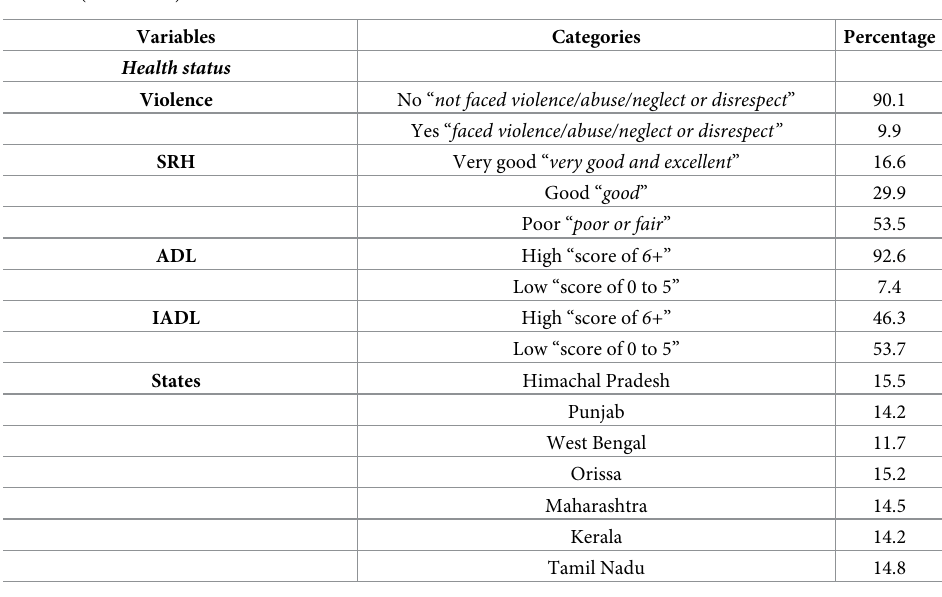
Fig 1A and 1B represent the percentage of living alone/with spouse and reason for living alone/with a spouse. Nearly 21% of older adults were living alone/with a spouse. Additionally, those older adults who lived alone/with spouse had giver specific reasons, i.e. about 14.6% told that they had no children, 47.3% of older adults said that they had their children away and 15.9% of older adults said they live alone/with a spouse because they had a family conflict. Table 2 presents the bivariate association between older adults preferring to live separately over different background variables. We are not discussing these estimates and will primarily focus on adjusted estimates in Table 3 as they provide precise estimates as controlled for back- ground factors. Table 3 represents the probit estimates for older adults who preferred separate living. Old- est-old men had a higher probability of preferred living separate than older adults from the young-old age group [Coef. 0.18, p < 0.05]. The older adults including men and women who were currently in the union had a higher probability of preferring living separate than older adults not in union (Total [Coef. 0.70, p < 0.05], Men [Coef. 0.62, p < 0.05]. Women [Coef. 0.72, p < 0.05].) Older adults including men and women who had years of schooling 11 years and above had a higher probability of preferring lining separate than older had no educational status (Total [Coef. 0.25, p < 0.05], Men [Coef. 0.21, p < 0.05] and Women [Coef. 0.42, p < 0.05]). The probability of preferring to live separately was low among urban residents than rural ones (Total [Coef. -0.18, p < 0.05], Men [Coef. -0.18, p < 0.05], and Women [Coef. -0.17, p < 0.05]). Older adults who were having absolute involvement in household activities had a lower probability of preferring living separate than older adults who had no involvement in house- hold activities (Total [Coef. 0.25, p < 0.05], Men [Coef. 0.21, p < 0.05], and Women [Coef. 0.42, p < 0.05]). The probability of preferring separate living was higher among older adults who had absolute involvement in decision making than those who had no role in decision making; however, the result is not significant. (Total [Coef. 0.13, p > 0.05], Men [Coef. 0.12, p >